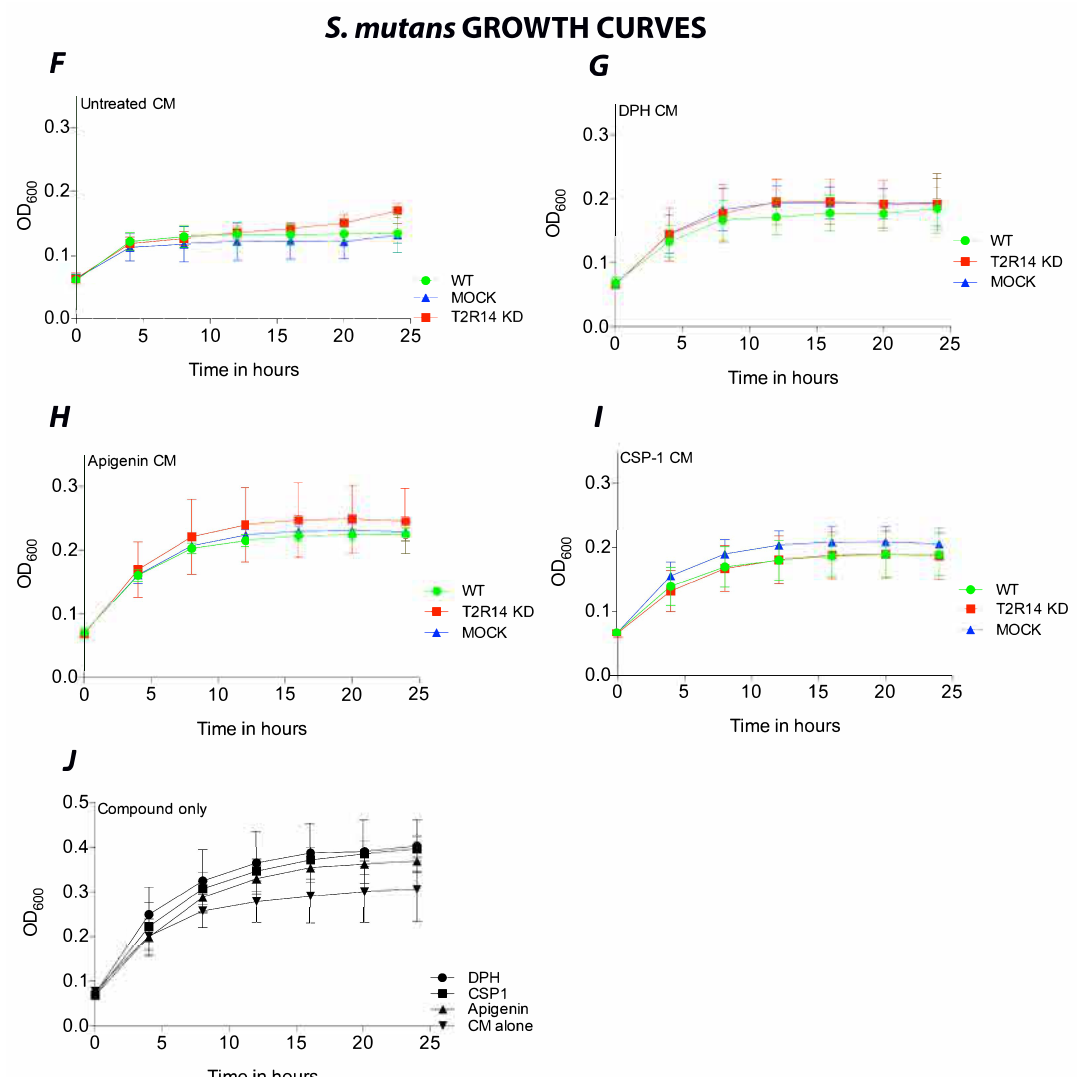
Figure 4. Characterizing the bactericidal effect of T2R14 on S. aureus and S. mutans . Real-time analysis of bacterial growth over 24 h measured at OD 600 . ( A – E ) Real-time growth curves of S. aureus in response to WT, MOCK and T2R14 KD CM alone or with T2R14 agonists DPH (250 µ M), CSP-1 (50 µ M), apigenin (50 µ M) and compound alone treatment. ( F – J ) Real-time growth curves of S. mutans in response to WT, MOCK and T2R14 KD CM alone or with T2R14 agonists DPH (250 µ M), CSP-1 (50 µ M), apigenin (50 µ M) and compound alone treatment. The data represented in the graphs are SEM of ≥ 3 independent experiments. One-way ANOVA analysis, using Tukey’s multiple comparison analysis, was performed, and the observed p -value is * p <